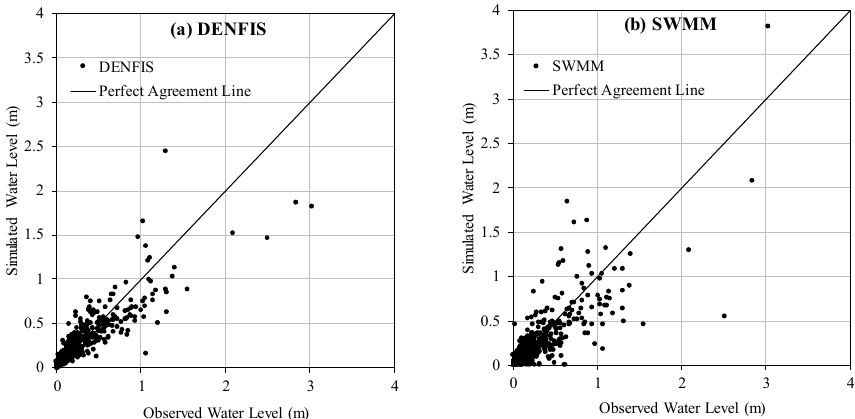
Figure 8. Observed versus simulated river stage by: ( a ) DENFIS, and ( b ) SWMM models in Dandenong catchment.